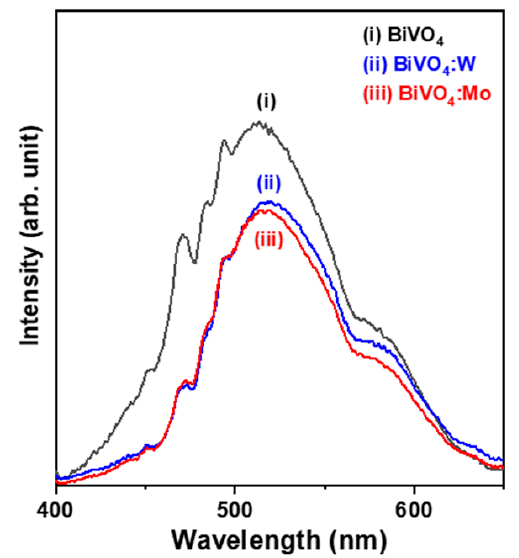
Figure 5. Raman spectra of undoped and impurity-doped BiVO 4 powder samples.